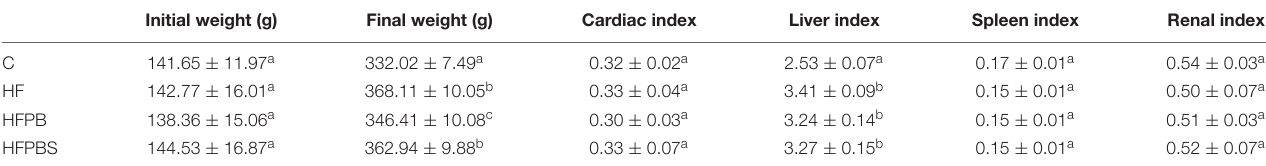
TABLE 3 | Body weight and organ